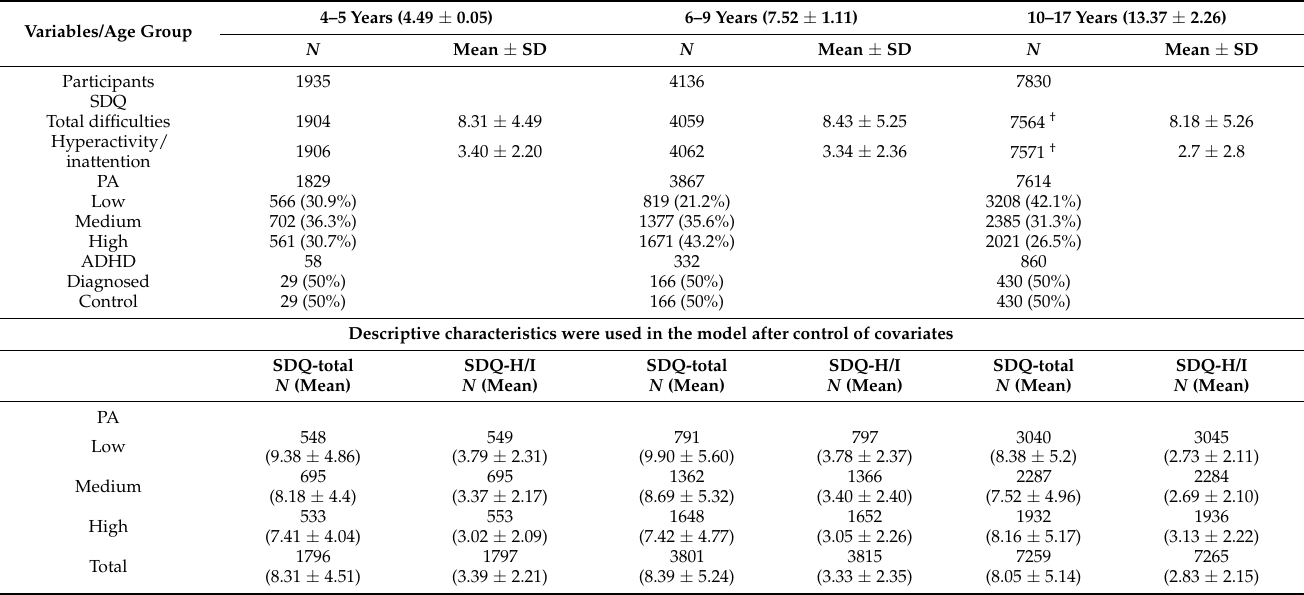
Table 1. Descriptive characteristics of the study population at